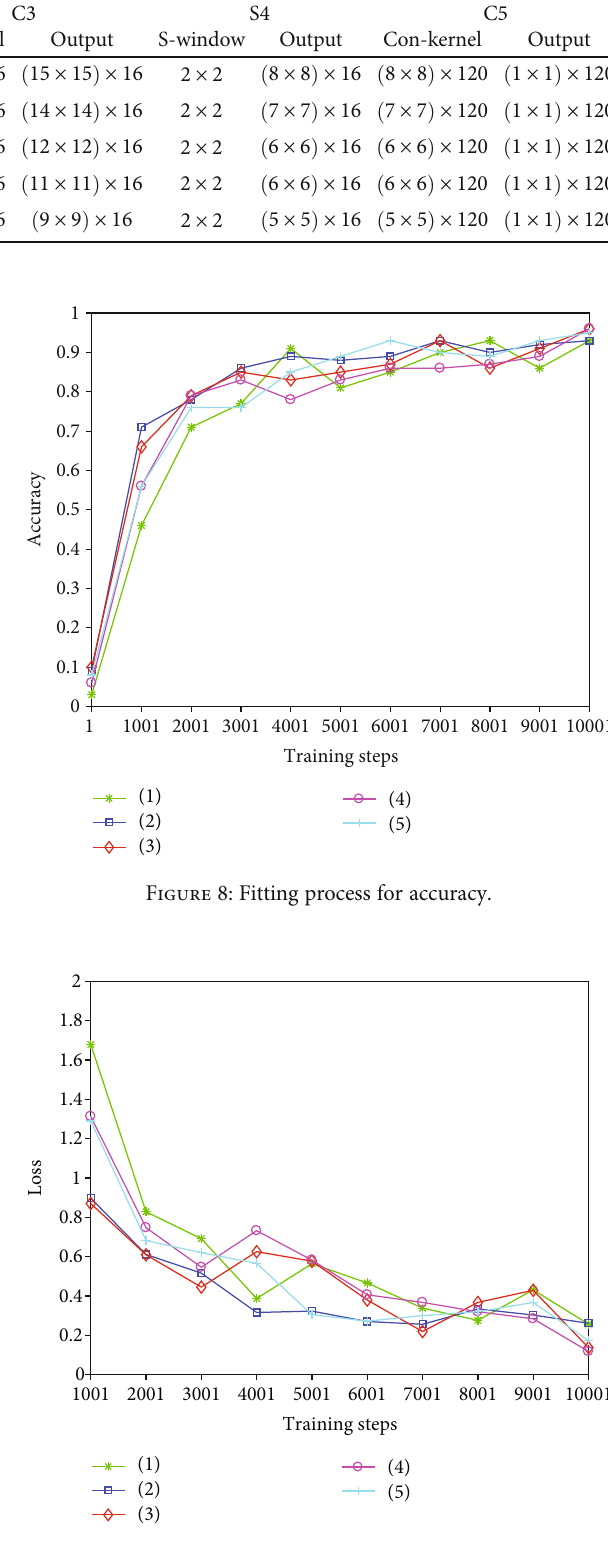
Figure 9: Fitting process for